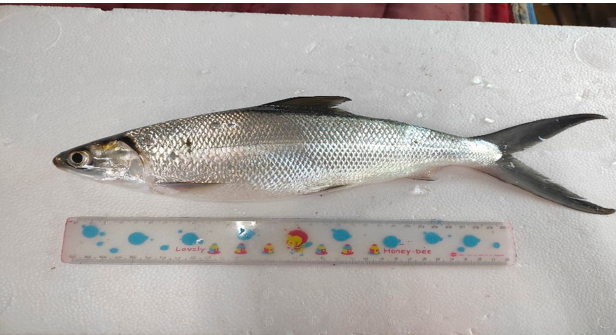
Figure 1. The Milkfish ( Chanos chanos ) is 5 months, old; one tail is around 1.3 or 1.4 catty. Generally, Milkfish fry stocks at the size of 6 inches in February and March.